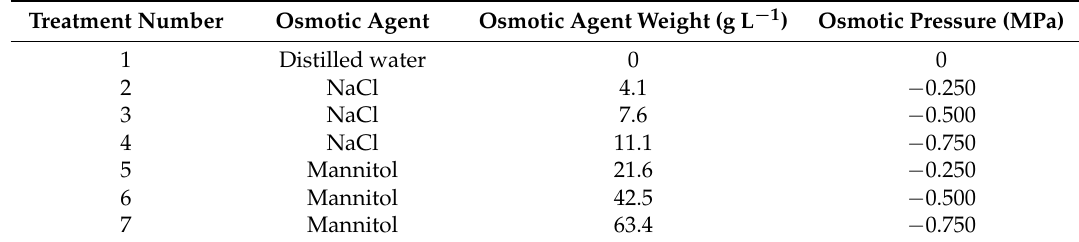
Table 1. Proso millet fresh weight yield components of main culm